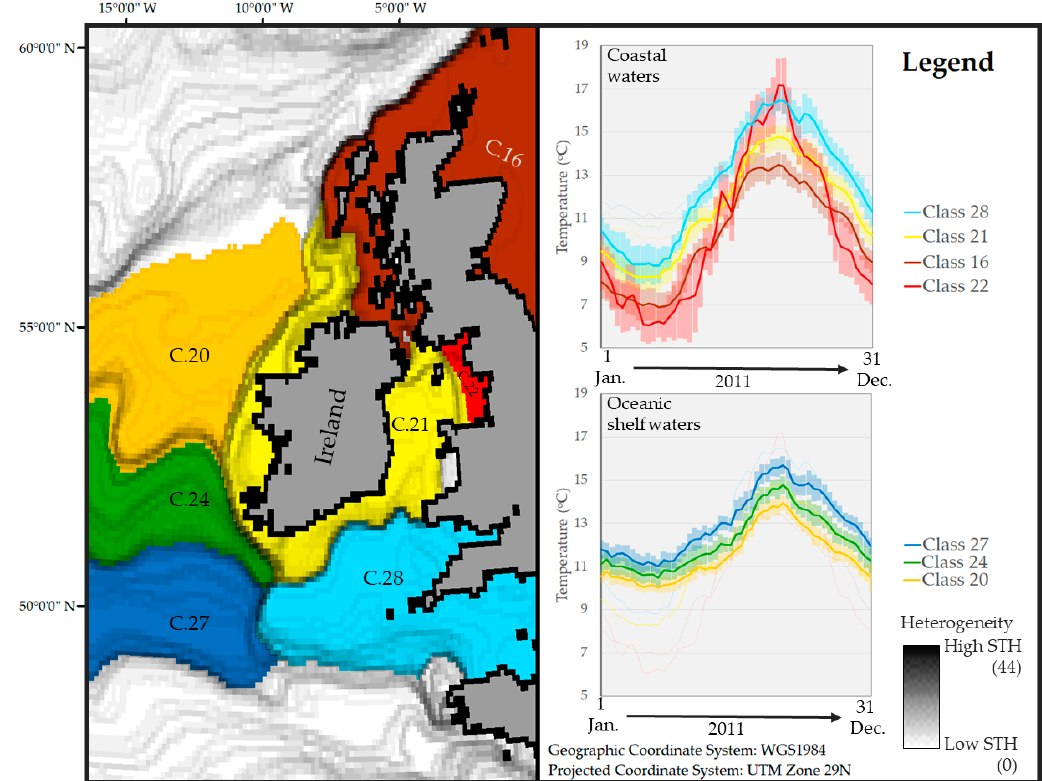
Figure 12. Coastal and pelagic surface spatio-temporal heterogeneity around Ireland. The map shows the distribution of seven water classes in, and adjacent to, the Celtic and Irish Seas, overlaid by the STH dataset. The legend contains the temporal profiles described by their means and standard deviation, for those classes linked to the coastline, and those pelagic classes further out to sea. Colours are simply used to visualize a class, they do not denote any scale or gradient in temperature between classes.